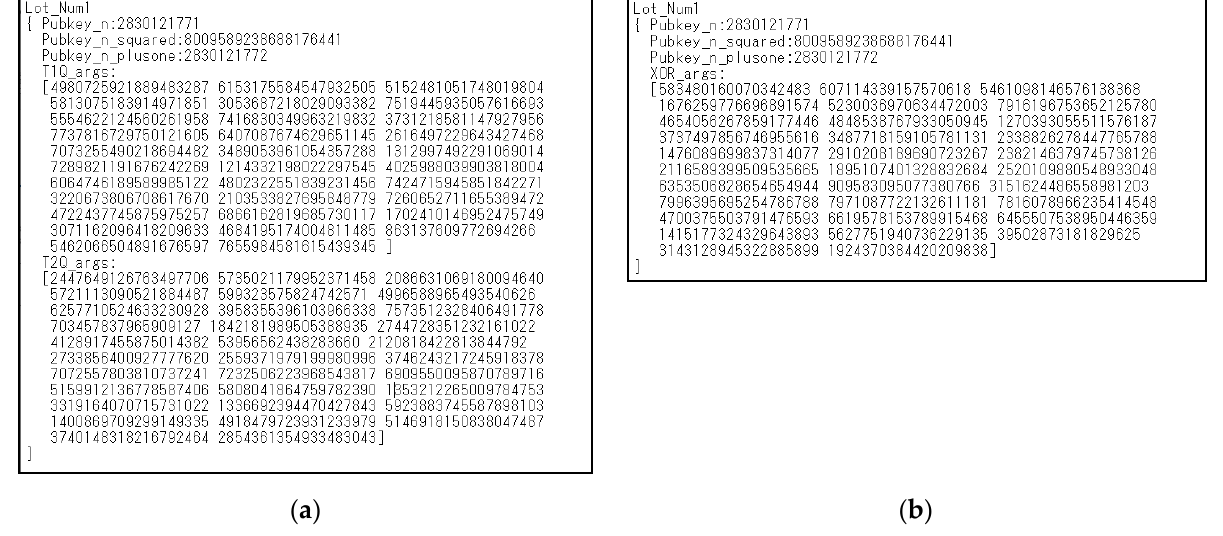
Figure A1. Data structure. ( a ) Data structure of 𝑄 (cid:3081) CC; ( b ) Data structure of XOR CC.